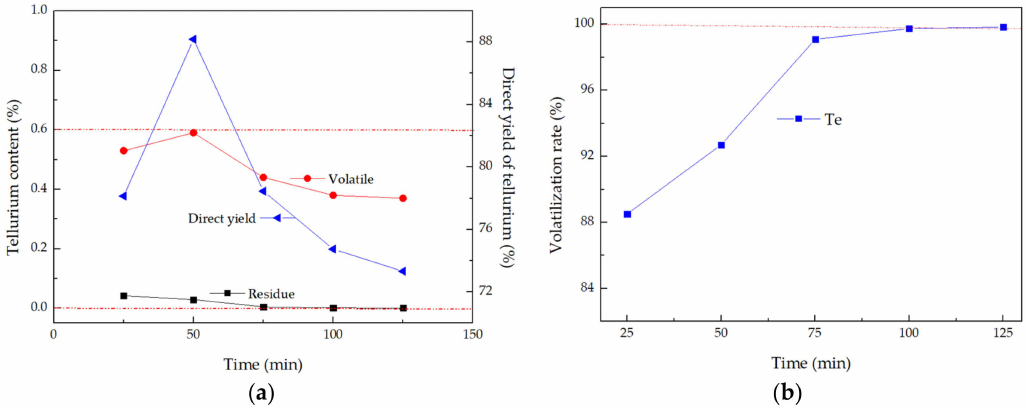
Figure 7. Effect of constant temperature time on separation of tellurium from TLAS. ( a ) content and direct yield, ( b ) volatilization rate.